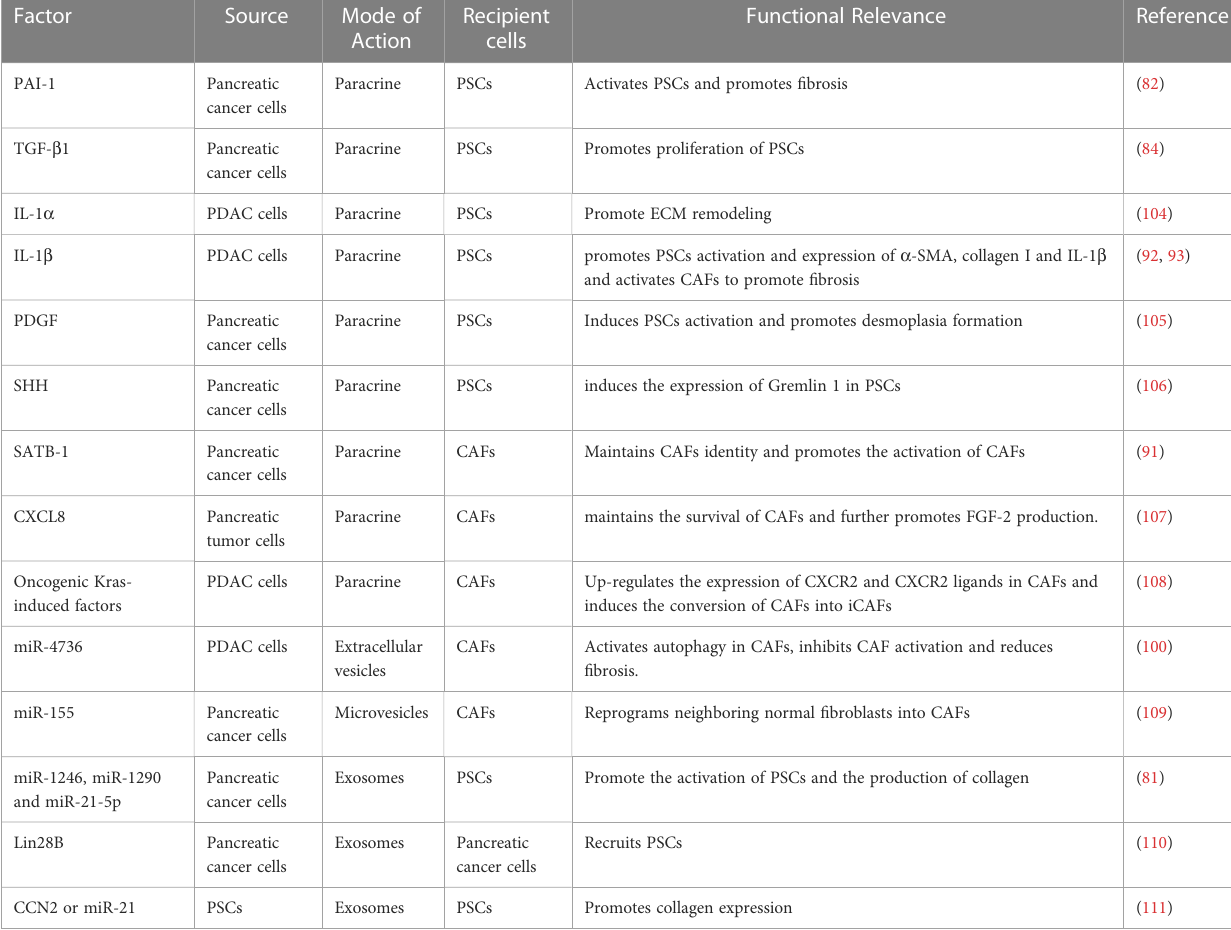
TABLE 1 Overview of the impact of crosstalk between CAFs and tumor cells on fi